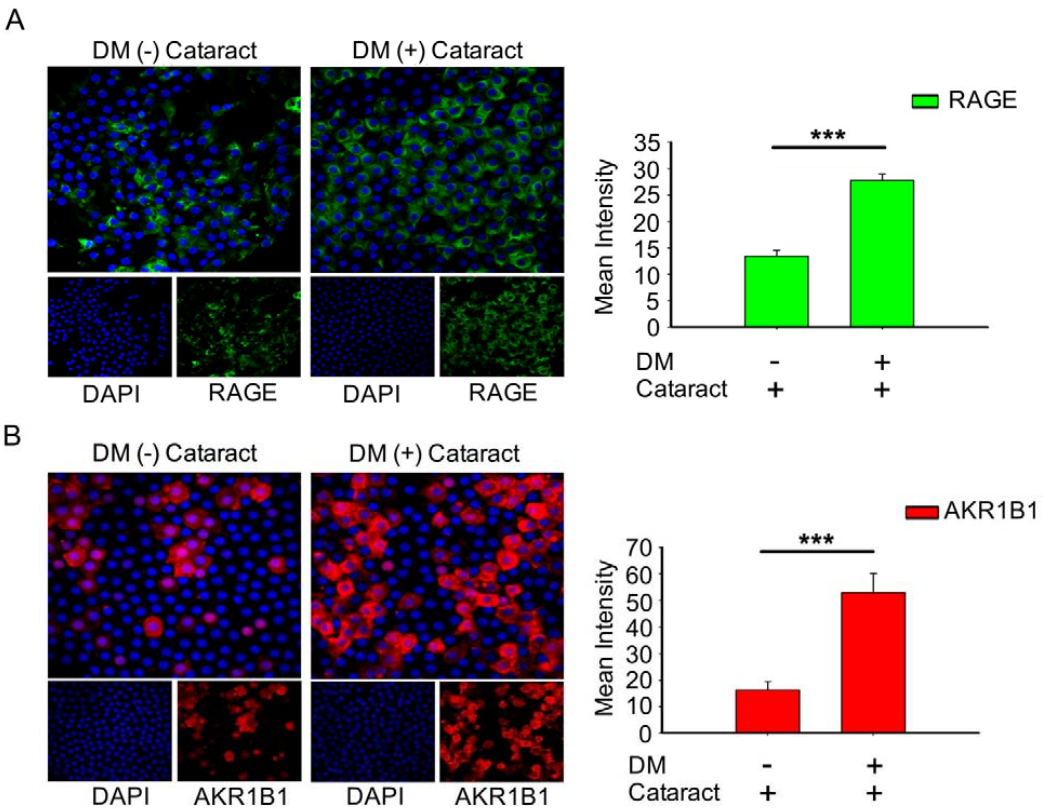
Figure 2. Expression of receptor for advanced glycation end products (RAGE) and AKR1B1 were higher in the lens in DM ( + ) cataract patients than in DM ( − ) cataract patients. ( A ) Representative green fluorescence images of green RAGE-positive and ( B ) red AKR1B1-positive cells in human lens epithelial sections from DM ( + ) or DM ( − ) cataracts. Cell nuclei were counterstained with DAPI (blue). Values are presented as means ± SEMs ( n = 10 per group, separate experimental groups in each figure). *** p < 0.001.